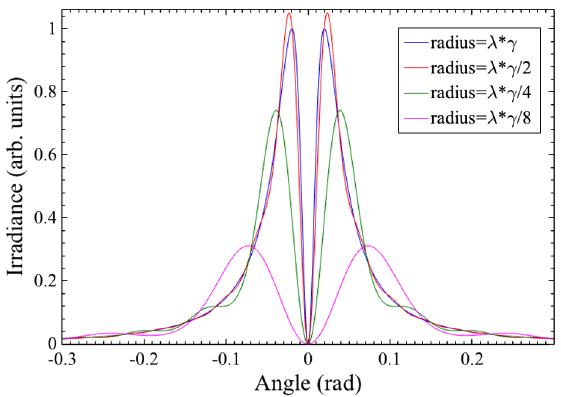
FIG. 2. The far-field OTR angular distribution calculated by ZEMAX for different OTR field radius ( λ ¼ 550 nm; γ ¼ 50